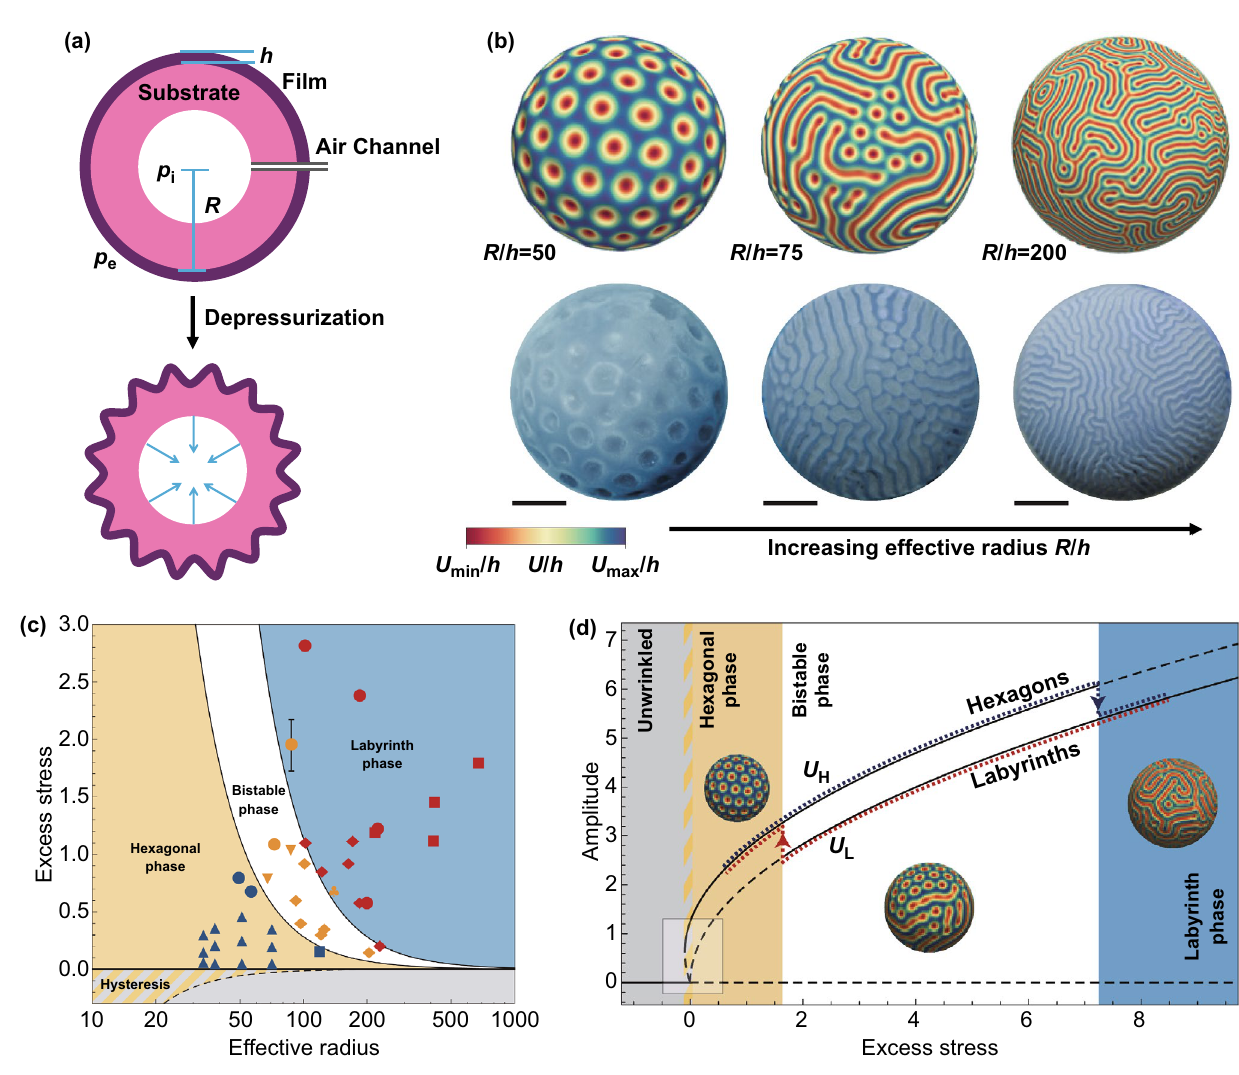
Fig. 9 Simulations and fabrications of wrinkling patterns on hollow elastic core–shell spheres. a Schematic illustrates the process for the wrin- kling of a hollow elastic sphere coated with a thin film. R and h represent the outer radius of the sphere and the film thickness, p i and p e represent the inner and outer pressure. The compressive stress can be controlled by tuning the pressure difference, Δ p = p e − p i . b Simulated wrinkling pat- terns based on steady-state solutions and fabricated wrinkling patterns demonstrate the hexagonal-to-labyrinth transition via a bistable state with increasing effective radius R / h . Scale bars 10 mm. c Phase diagram of wrinkling morphologies. Experimental data points for hexagonal (blue), bistable (yellow), and labyrinth (red) patterns are shown in the graph, and solid lines are theoretically predicted phase boundaries. d Bifurca- tion diagram of wrinkling patterns, where R / h = 40, solid and dashed lines represent stable and unstable amplitude solutions respectively